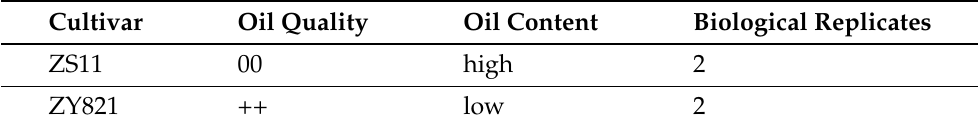
Table 2. Meta data of the RNA-Seq experiment samples which were used for differential expression analysis. ZS11 and ZY821 stand for Zhongshuang11 and Zhongyou821, respectively. 00 and ++ stand for low erucic acid, low glucosinolate and high erucic acid, high glucosinolate,